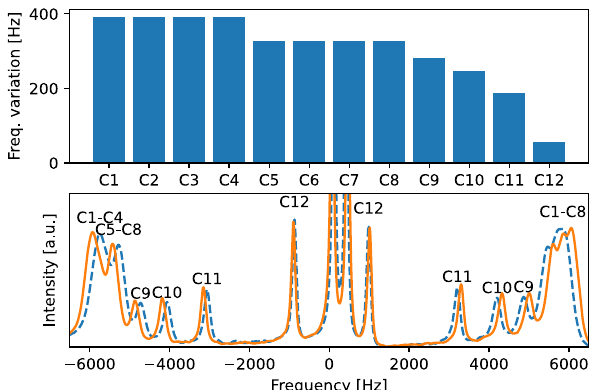
2 Figure 1. H-NMR spectra of SDS-based membrane mimetic enriched with SDS-d 25 . Lower plot shows a comparison between samples with TP1 peptide (orange continuous line) and without it(blue dashed line). Upper plot show the variation in the quadrupolar splitting induced by the presence of TP1 peptide in the